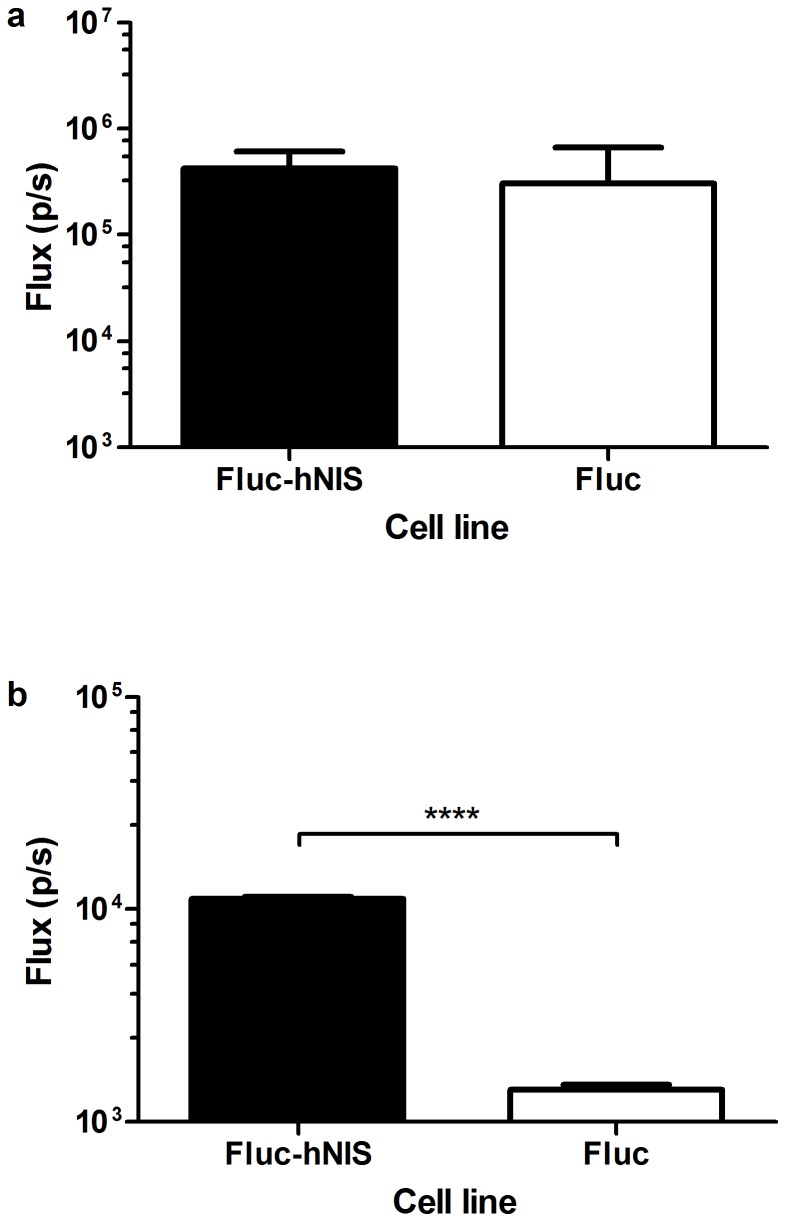
In vitro optical validation of the imaging reporter genes.In vitro BLI (a) and CLI (b) of Fluc-hNIS expressing MSCs and Fluc expressing MSCs. ****: p<0.0001.